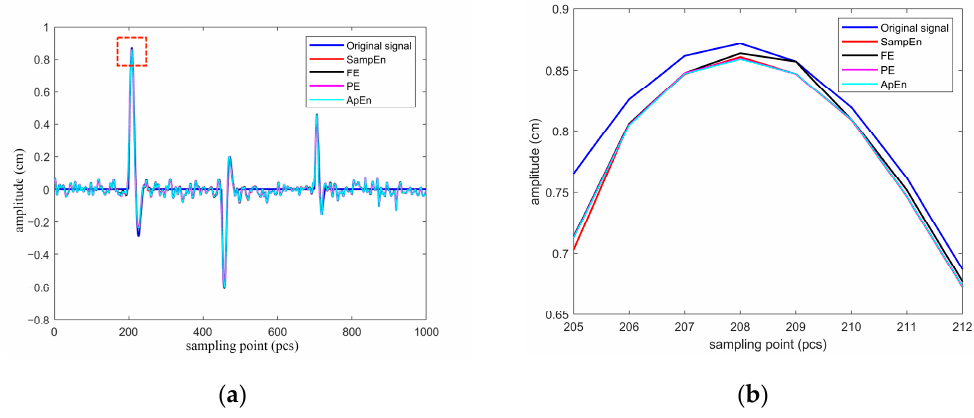
Figure 7. Denoising results of the synthetic data. ( a ) Original signal and the denoising result with different discriminant factors. ( b ) Local amplification of wave peak.